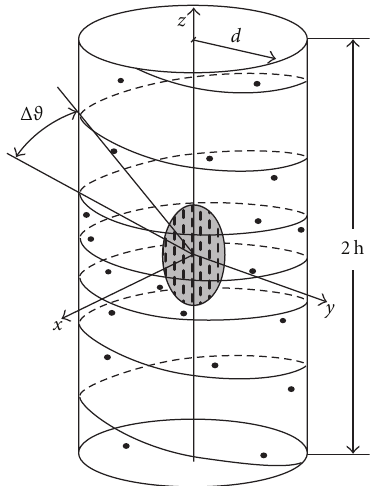
Figure 1: Geometry of the